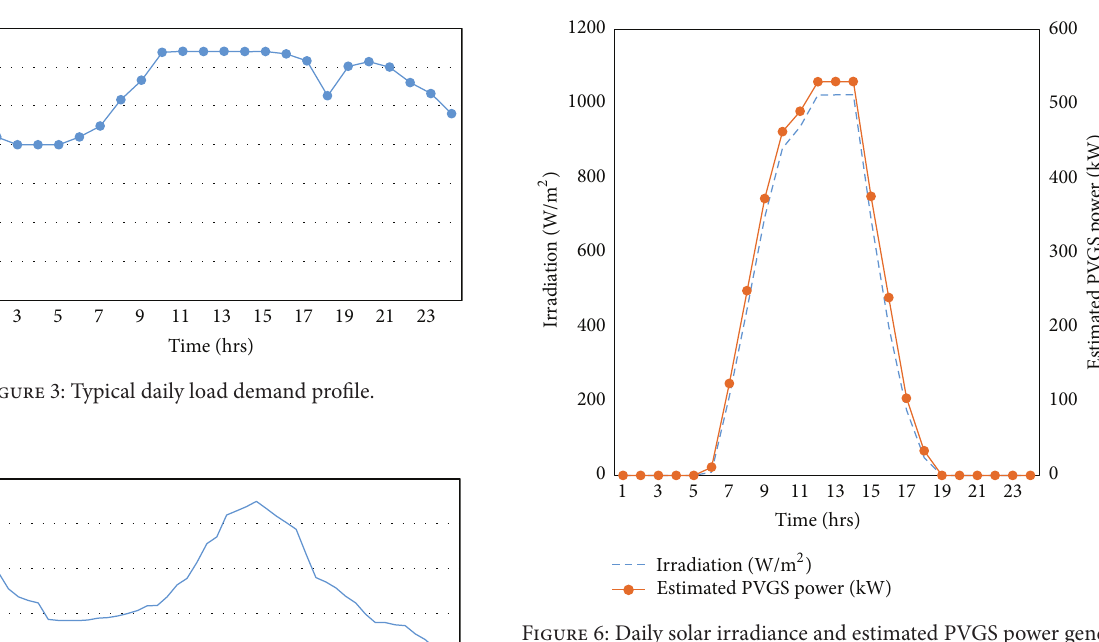
Figure 6: Daily solar irradiance and estimated PVGS power gener- ation at sunny day.